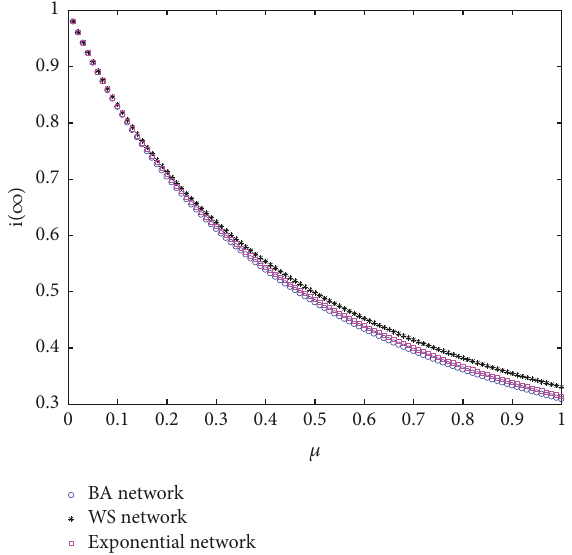
Figure 8: Effects of the recovery rate 𝜇 of health food consumers on the scale 𝑖(∞) of the health food safety scare behavior diffusion under three kinds of network structures (where 𝜆 0 = 0.005 , 𝛽 = 0.5 , = 0.15 , and 𝑘 = 1000 𝜃 = 0.75 , 𝜂 𝑘